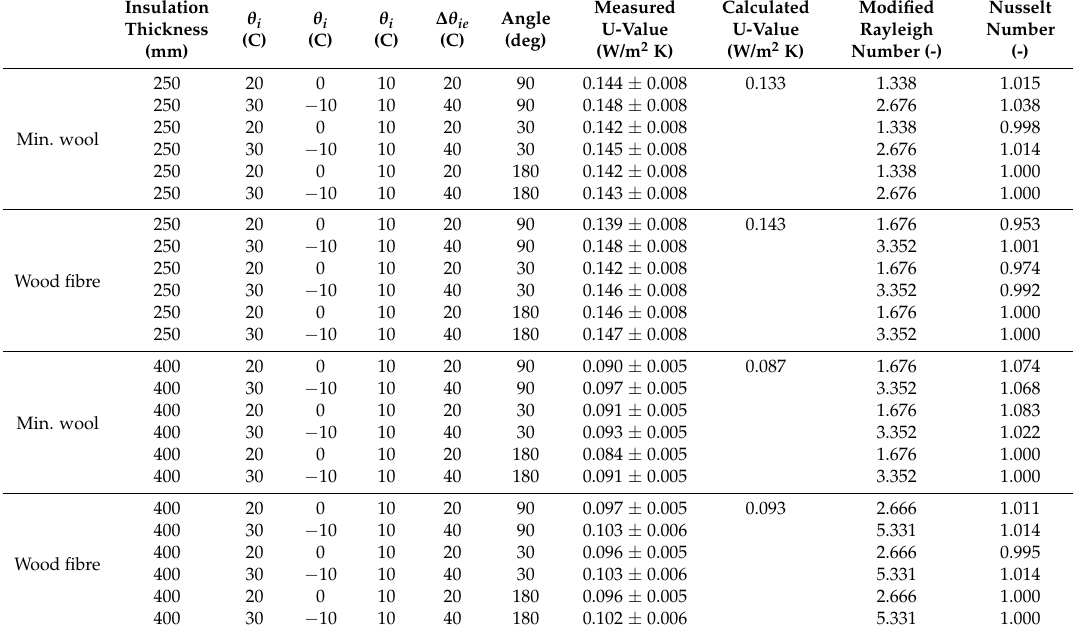
Table 4. Results from the Hot-Box